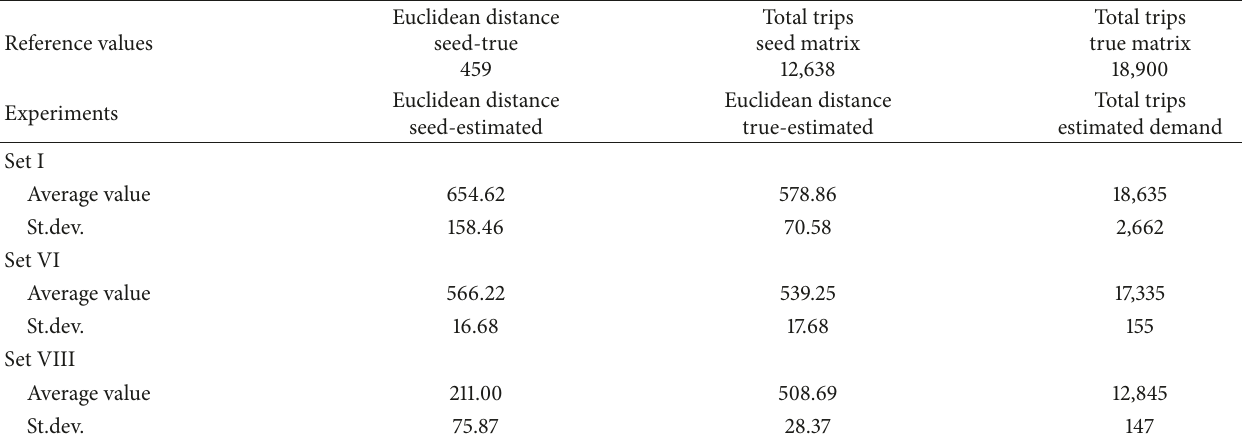
Table 8: Evaluation of the estimated demand as the Euclidean distance from the true O–D matrix and the total number of trips (adding O-D travel times).